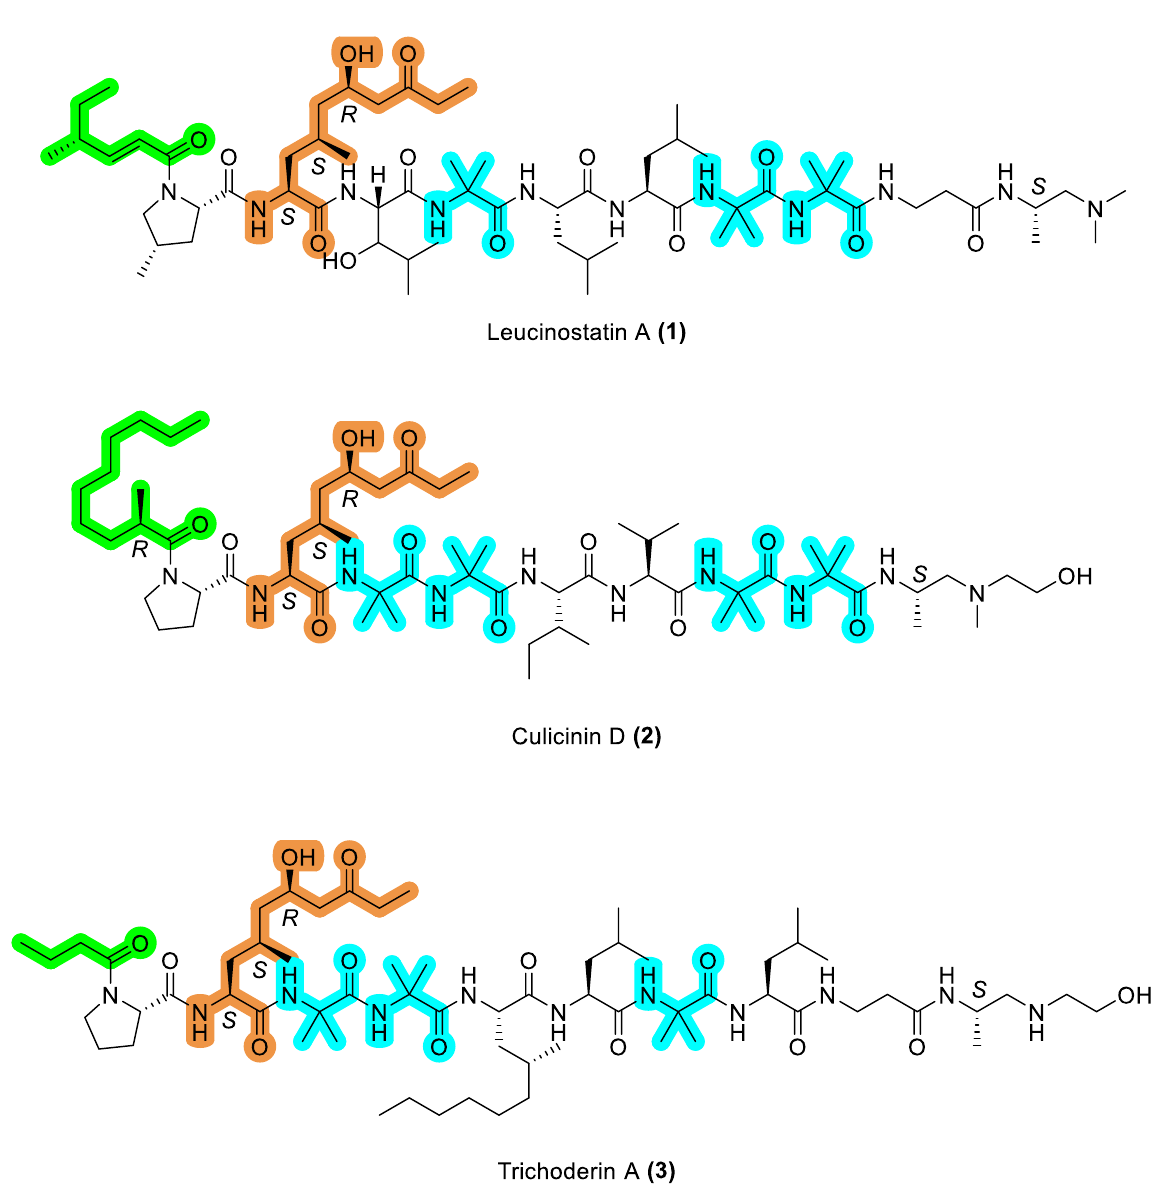
Figure 2. Comparative chemical structure of the AHMOD-containing aminolipopeptides leucino- statin A ( 1 ), culicinin D ( 2 ), and trichoderin A ( 3 ). Shared motifs are highlighted accordingly in color: N -terminus lipid tail (green), AHMOD (orange), Aib (blue).